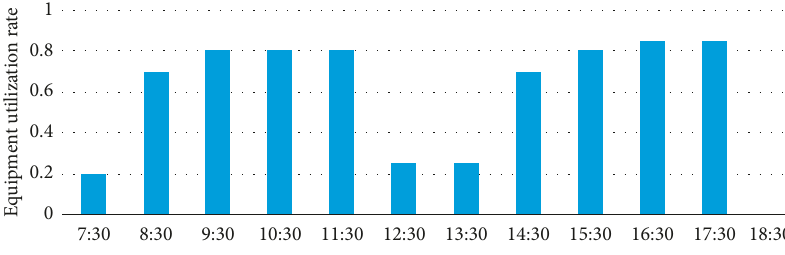
Figure 6: Dynamic change in equipment utilization in the office area. Table 4: Comparison between the building monthly energy consumption simulation value and the actual